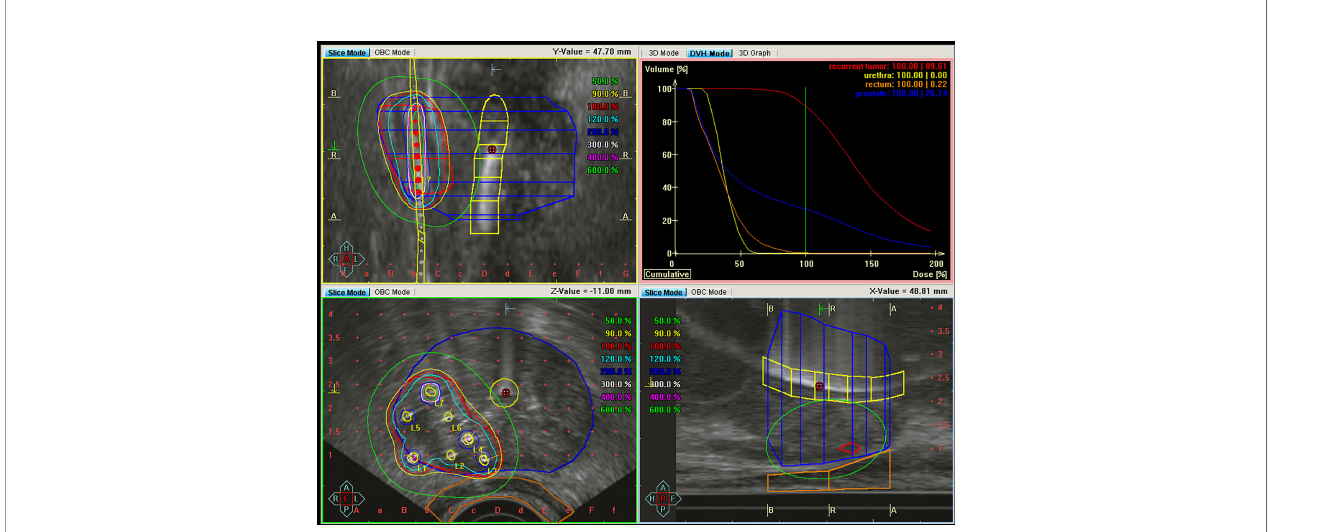
FIGURE 3 | Dose distribution for high dose-rate brachytherapy of the same patient as in Figure 2 showing the coronal (upper left), transversal (lower left), and sagittal (lower right) plane. The recurrent tumor (red), prostate (blue), urethra (yellow), and rectum wall (brown) are delineated. Air- fi lled gel has been inserted in the urethra catheter to visualize the urethra in the ultrasound images. The dose-volume histograms (upper right quadrant) show the highly conformal dose distribution, sparing the rectum and urethra, achieved by